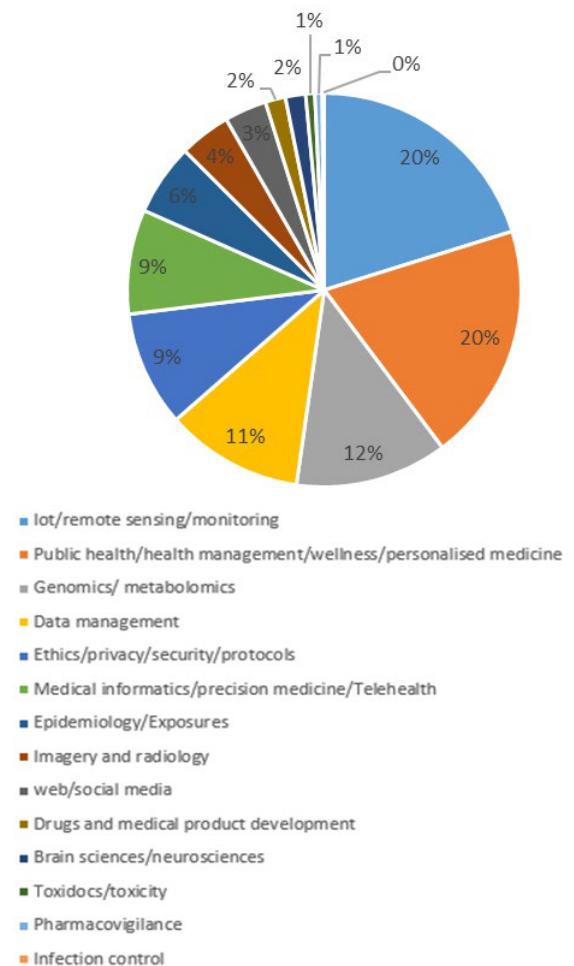
Table 3. Study template